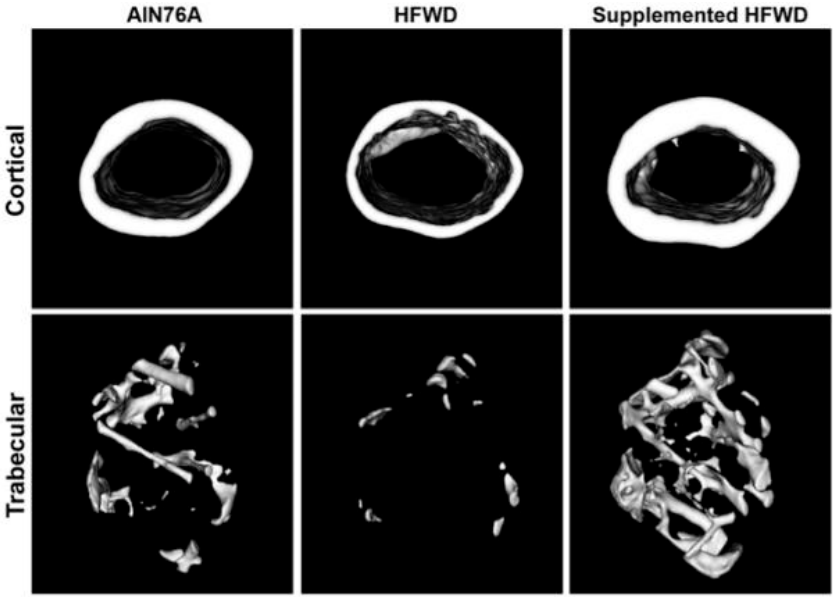
Figure 3. Micro-CT cross-sectional images of mid-diaphysis (cortical) and distal metaphysis (trabecular) regions of femora from female mice on low-fat (AIN76A), high-fat (HFWD) and high-fat supplemented with LithoLexal ® diets (adopted from Aslam et al.) [20].